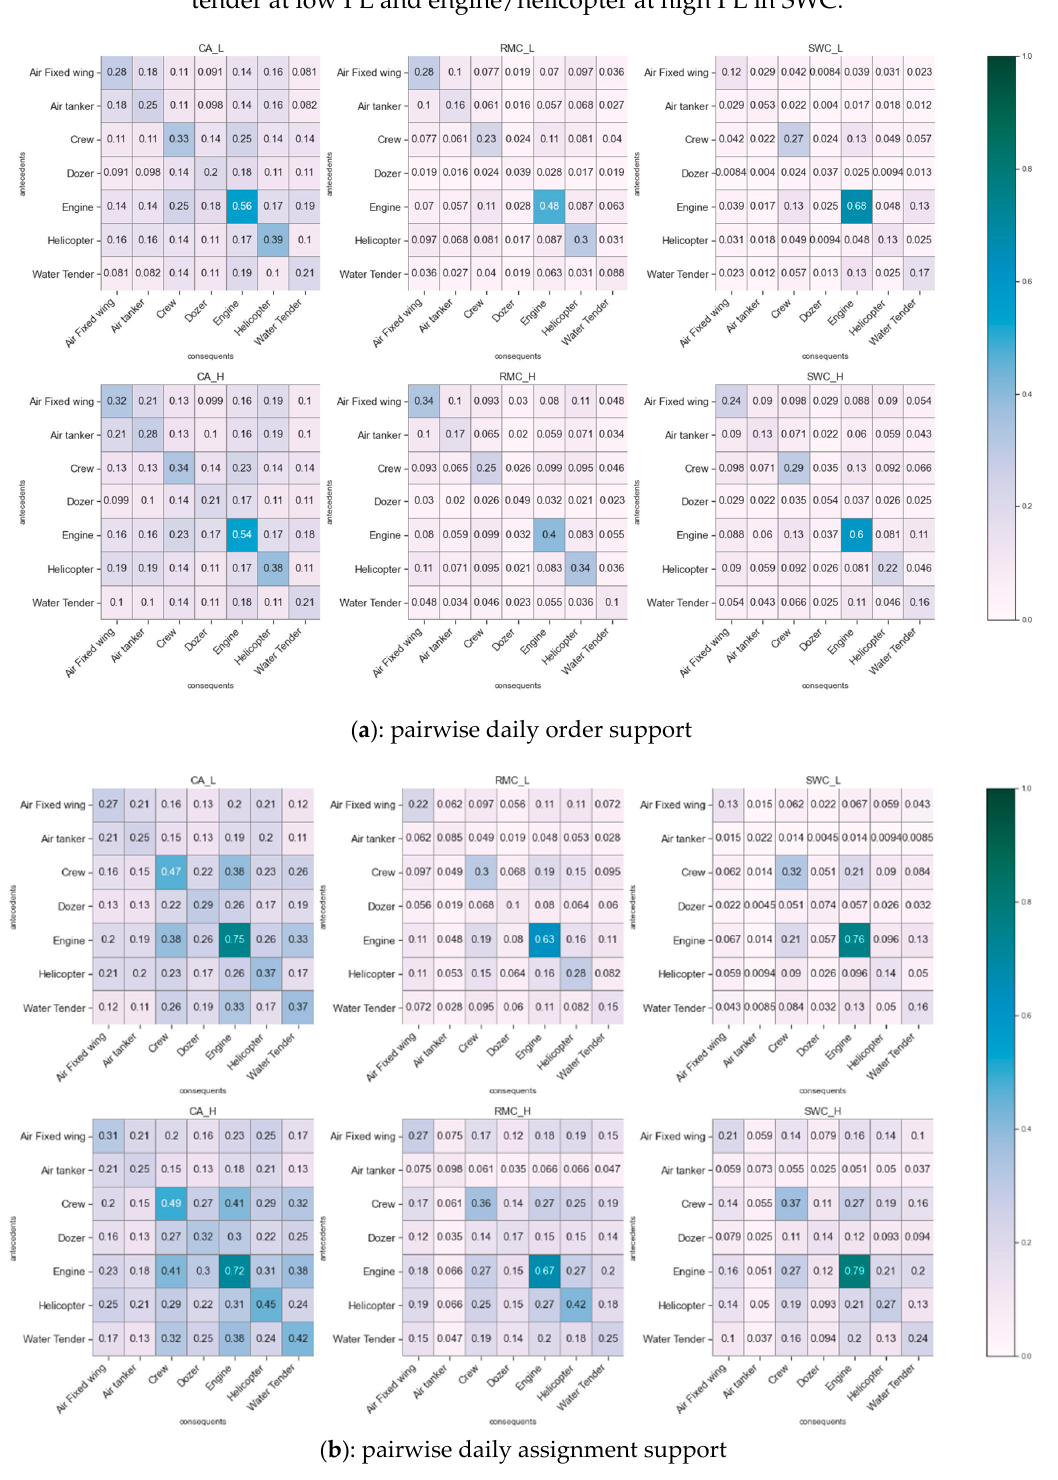
Figure 4. Support heatmaps for: ( a ) daily resource ordering and ( b ) daily resource assignments for three GACCs at both high and low PLs.